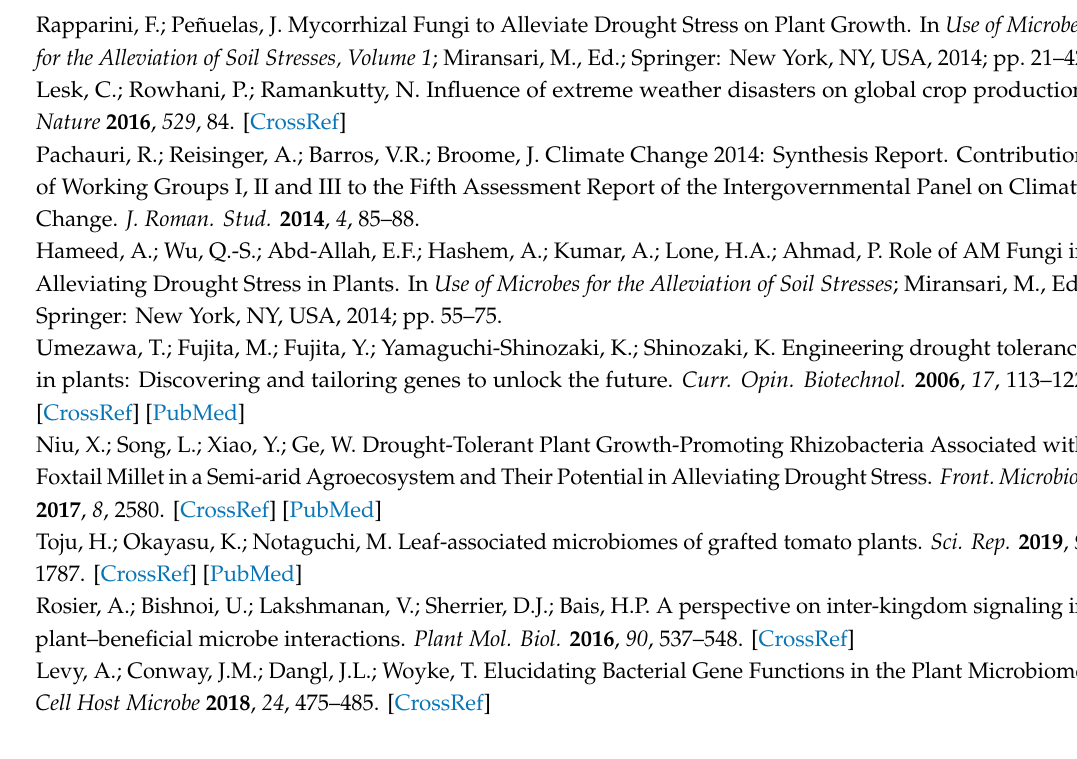
Figure S1: Representative images of rice inoculated with fungi compared to non-inoculated rice under well-irrigated and drought stress; Figure S2: Representative images of rice inoculated with endophyte and rhizosphere bacteria under well-irrigated and drought stress; Table S1: Identification of the fungal and bacterial isolates; Table S2: Plant growth promotion traits of the cultivable fungi and bacteria isolated from the upland rice roots Author Contributions: D.Y. and P.X. designed the experiments, Z.P. and Y.Z. performed the experiments and analyzed the data. Z.P. wrote the manuscript with the input from P.X. and D.Y. All authors have read and